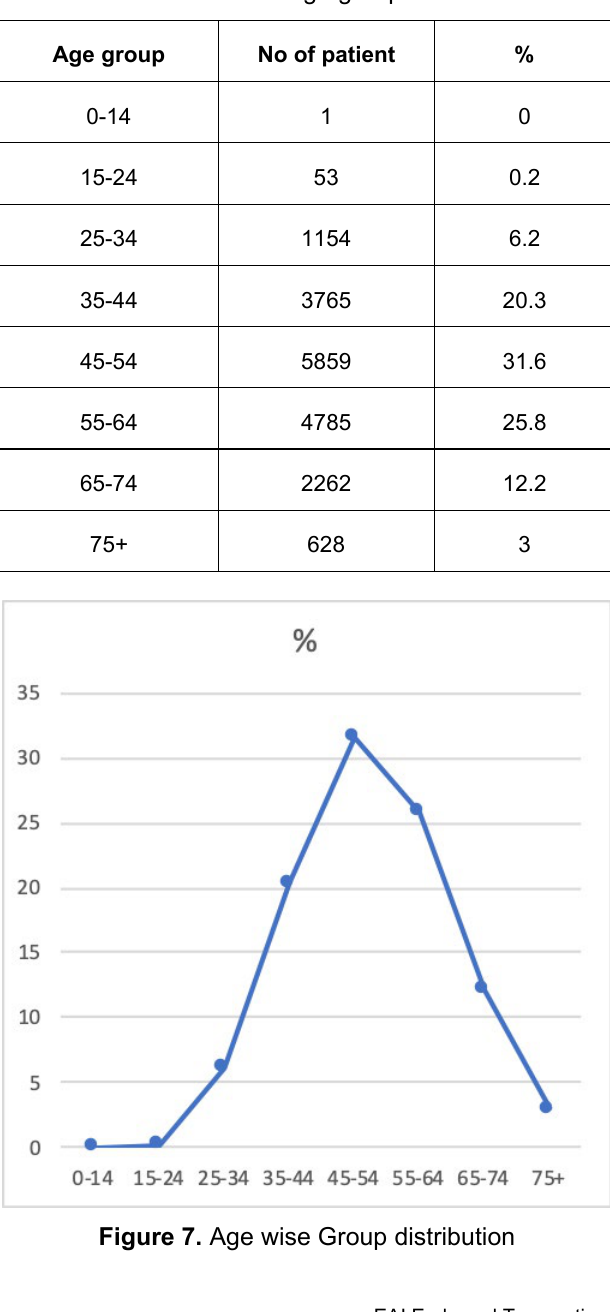
Table 3. Number of cases registered and % for different age groups.